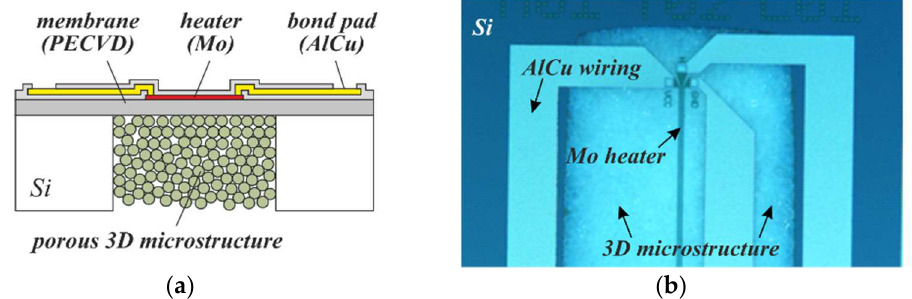
Figure 19. ( a ) Cross-section of a thin-film-membrane-based calorimetric flow sensor, whose backside cavity has been equipped with a 3D microstructure at the wafer level. ( b ) Optical image of the top side of a particular sensor design. The 3D microstructure can be seen through the transparent membrane.